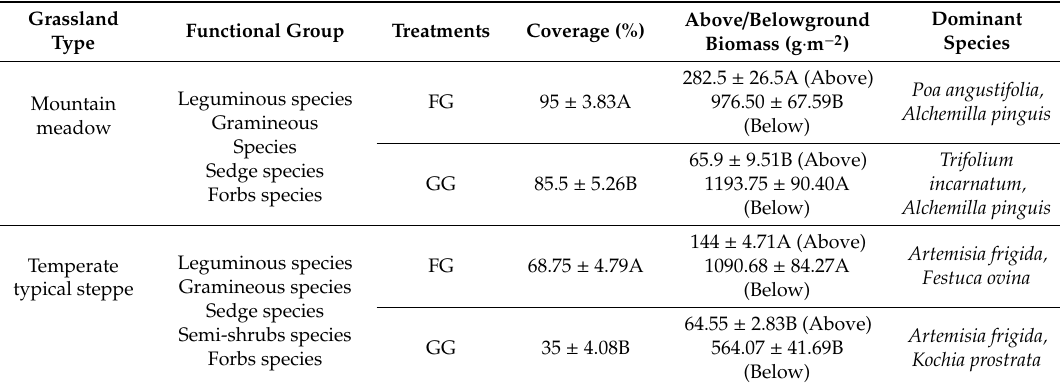
Table 2. The functional group and e ff ects of grazing on the plant coverage and biomass in MM and TTS